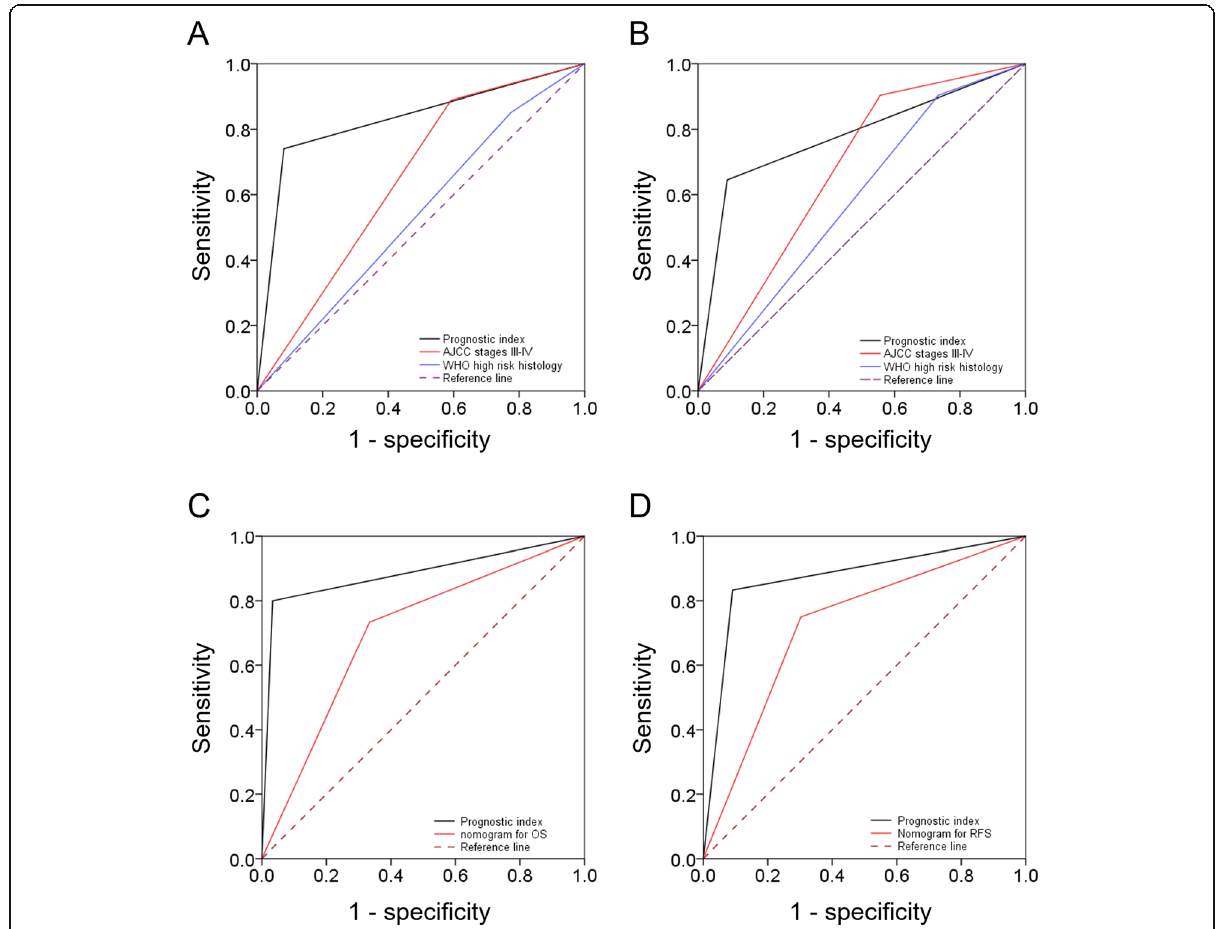
Fig. 4 Receiver operating characteristic (ROC) curves showing that the C-index of the prognostic model was higher than those of AJCC stage III − IV and WHO high-risk histology for both OS ( a ) and RFS ( b ). For surgically treated patients ( n = 45), the C-index of the prognostic model was higher than the nomogram for OS ( c ) and that for RFS ( d